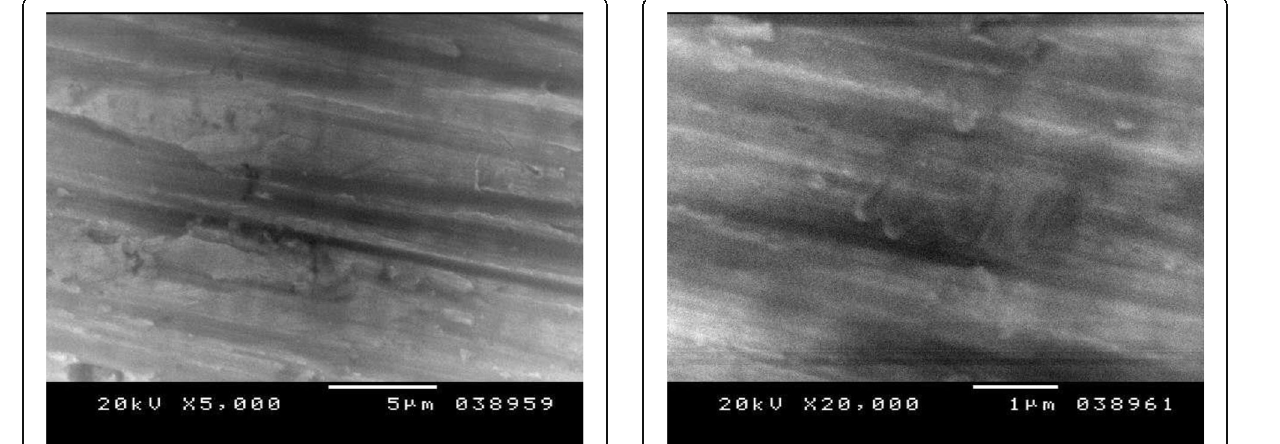
Fig. 9 Scanning electron microphotograph of control Cp titanium specimen at